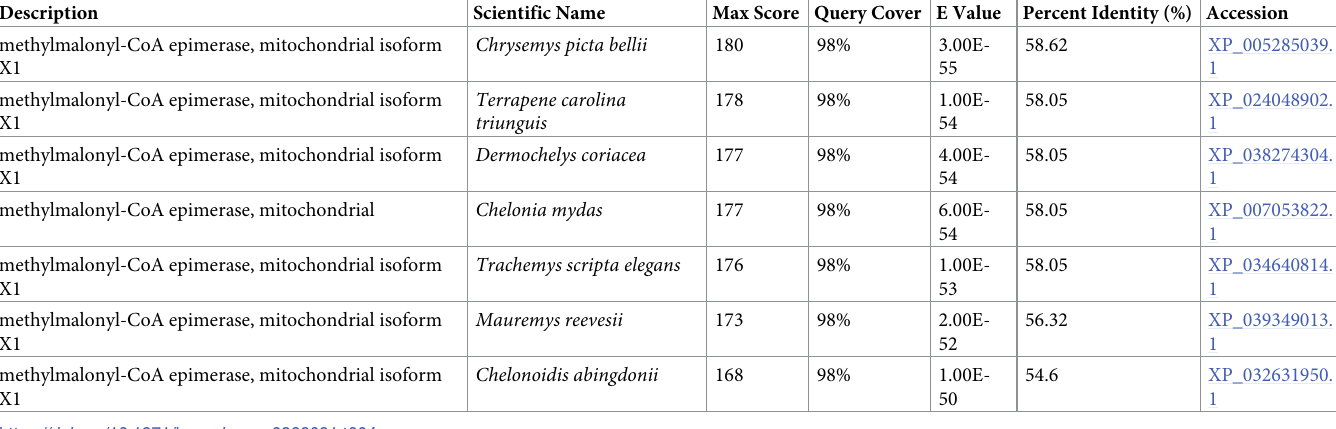
Table 4. BLAST output of the g112.t1 sequence before genome editing. Top hits predicted mitochondrial methylmalonyl-CoA epimerase with a high query coverage, moderate percent identity, and low E